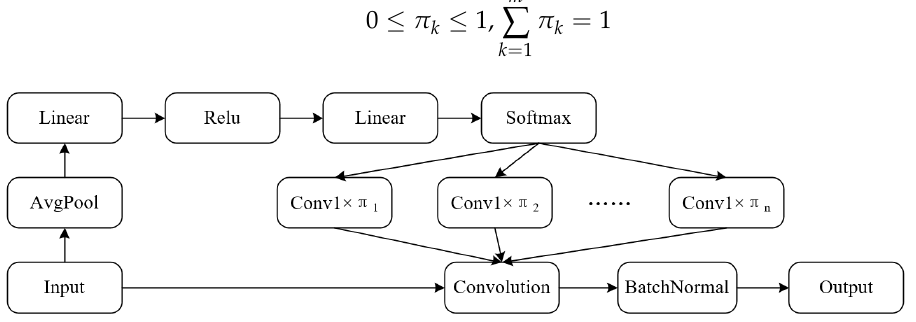
Figure 1. Introduction and calculation process of DY-CNNs.